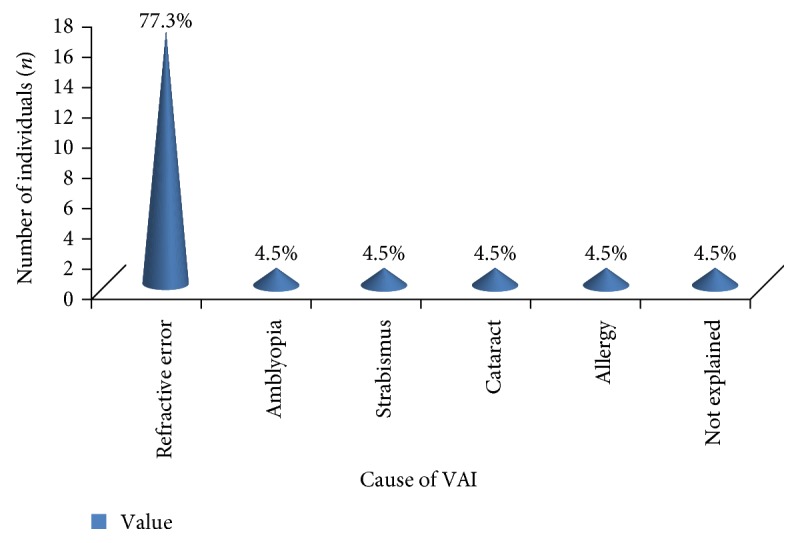
Cause of visual acuity impairment.